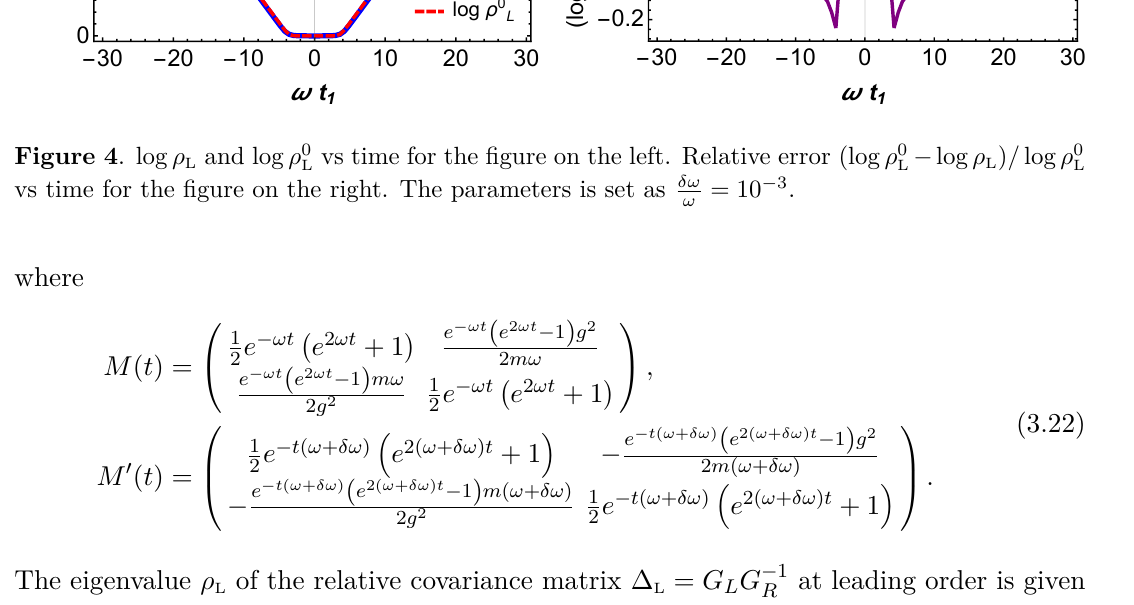
− log ρ ) / log ρ 0 L L L